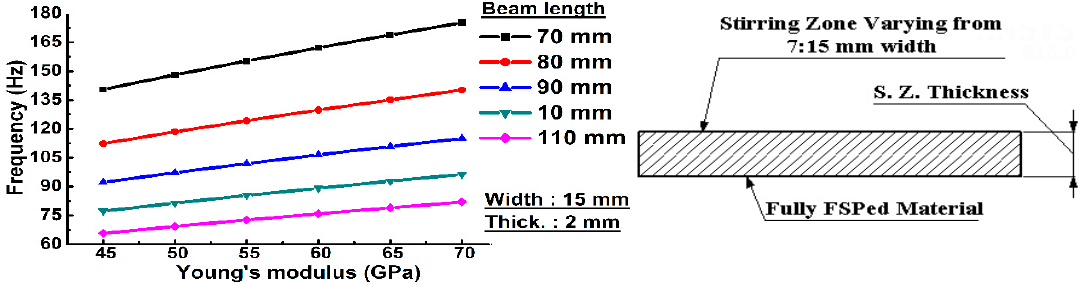
Figure 7. Effect of geometry on the dynamic properties for the fully composite beam, which was determined in a parametric study.